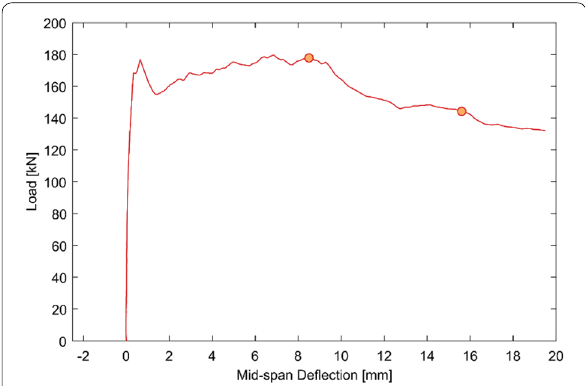
Fig. 10 Example of a resulting load versus mid-span deflection (Beam 14H). A bending crack appeared at the first peak, and after yielding of the reinforcement, anchorage failure of the tensile reinforcement bars took place one at a time; these are marked on the curve by